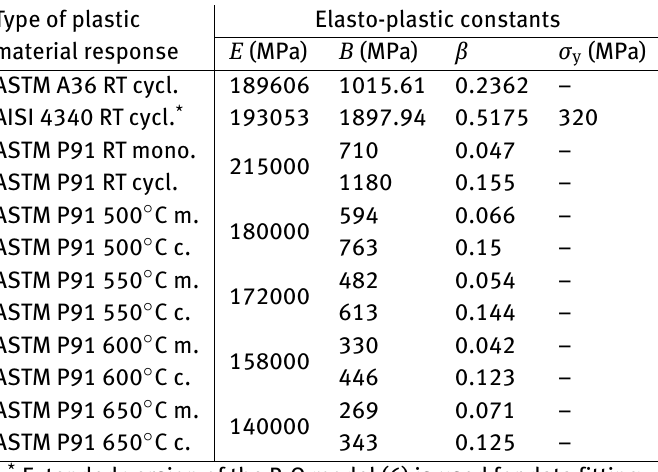
Table 1: Fitting parameters of the Ramberg-Osgood model (1) and (6) for different steels and